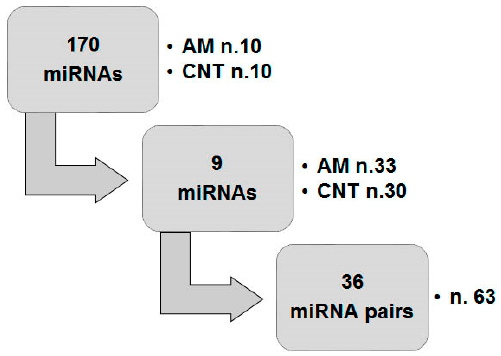
Figure 1. Work flow of the study.